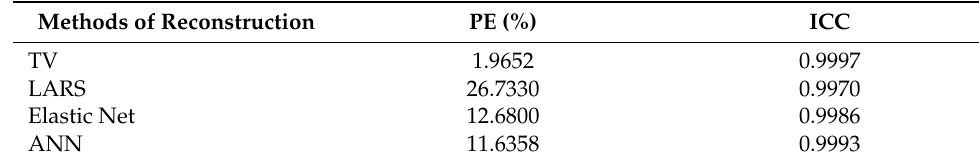
Table 2. Preliminary evaluation of algorithmic methods through